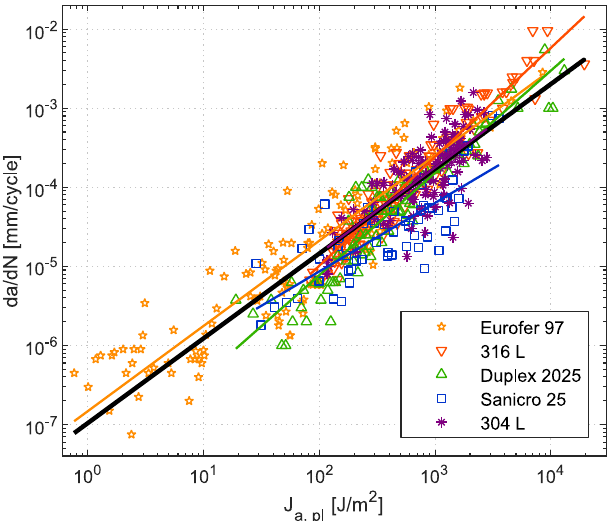
Figure 17. Short crack growth rate vs. plastic part of J-integral amplitude under cycling with total strain amplitude ε a ; ( a ) Sanicro 25, ε a = 0.25%–0.7%, ( b ) 304L, ε a = 0.4%–0.7%. All data points are fitted by a black curve.